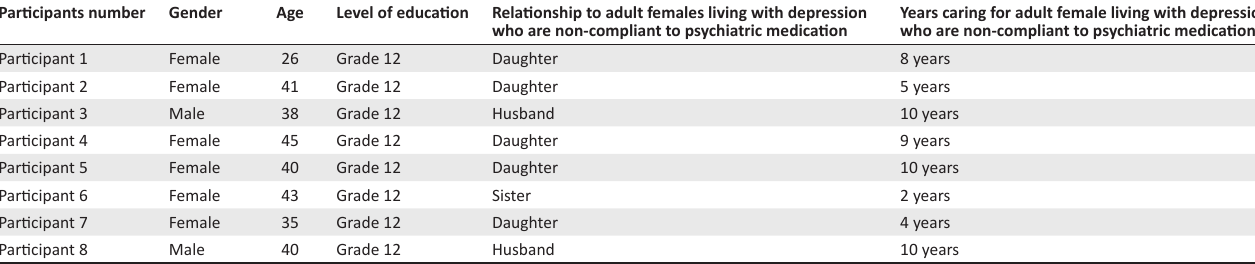
TABLE 1: Demographic data of participating family